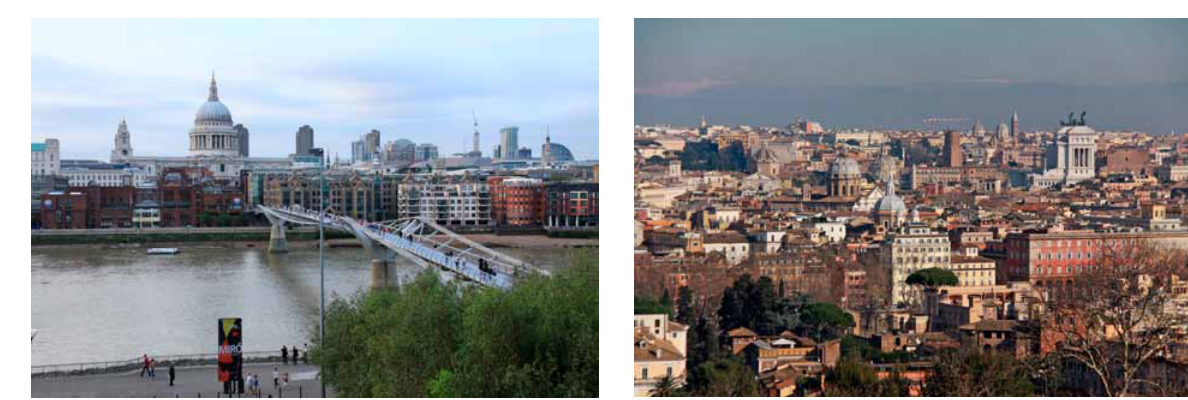
fig. 9. reconstruction of the center of frankfurt (Germany). The new city silhouette formation